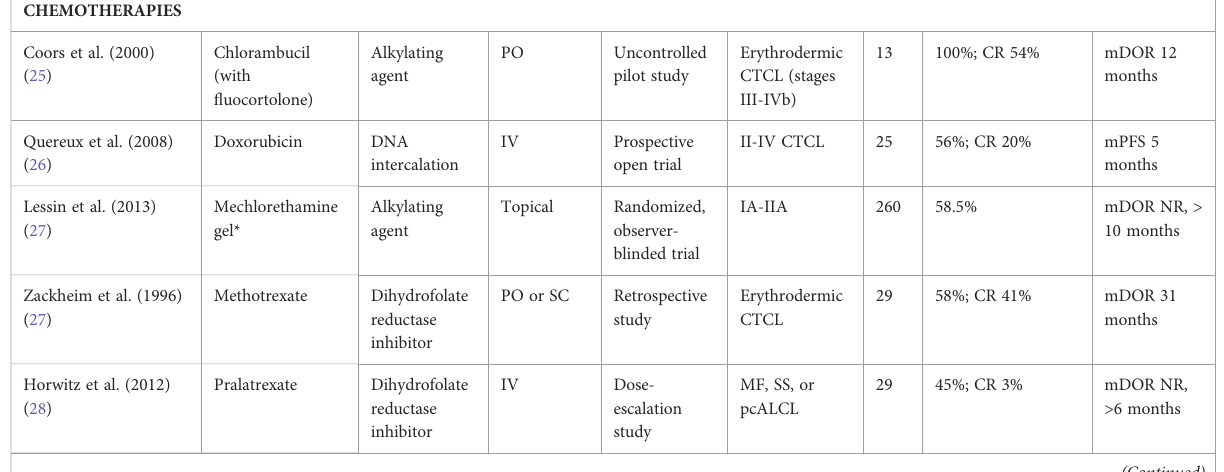
TABLE 3 Chemotherapies and radiotherapies for the treatment of